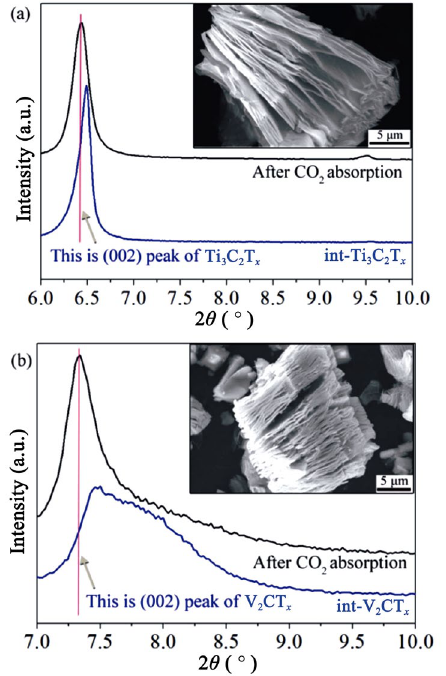
Fig. 7 XRD patterns and SEM images of (a) int-Ti 3 C 2 T x and (b) int-V 2 CT x after CO 2